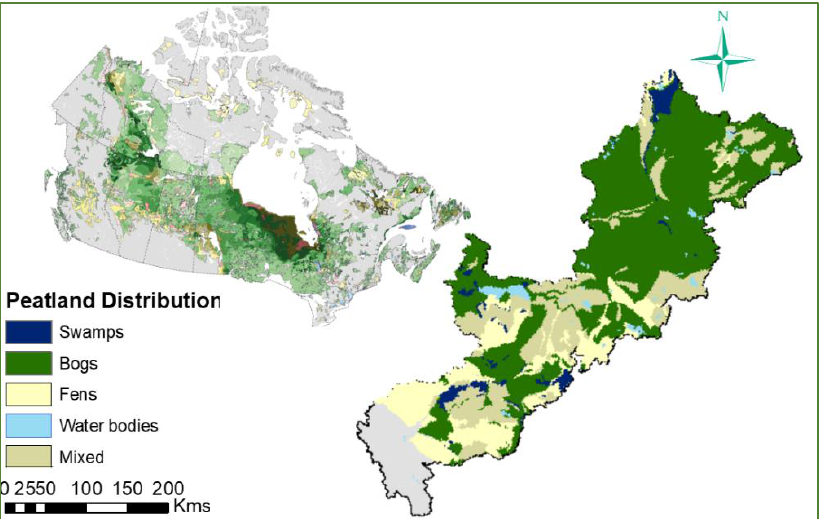
Figure 2. Wetland distribution in the study ’s river basin and Canada.